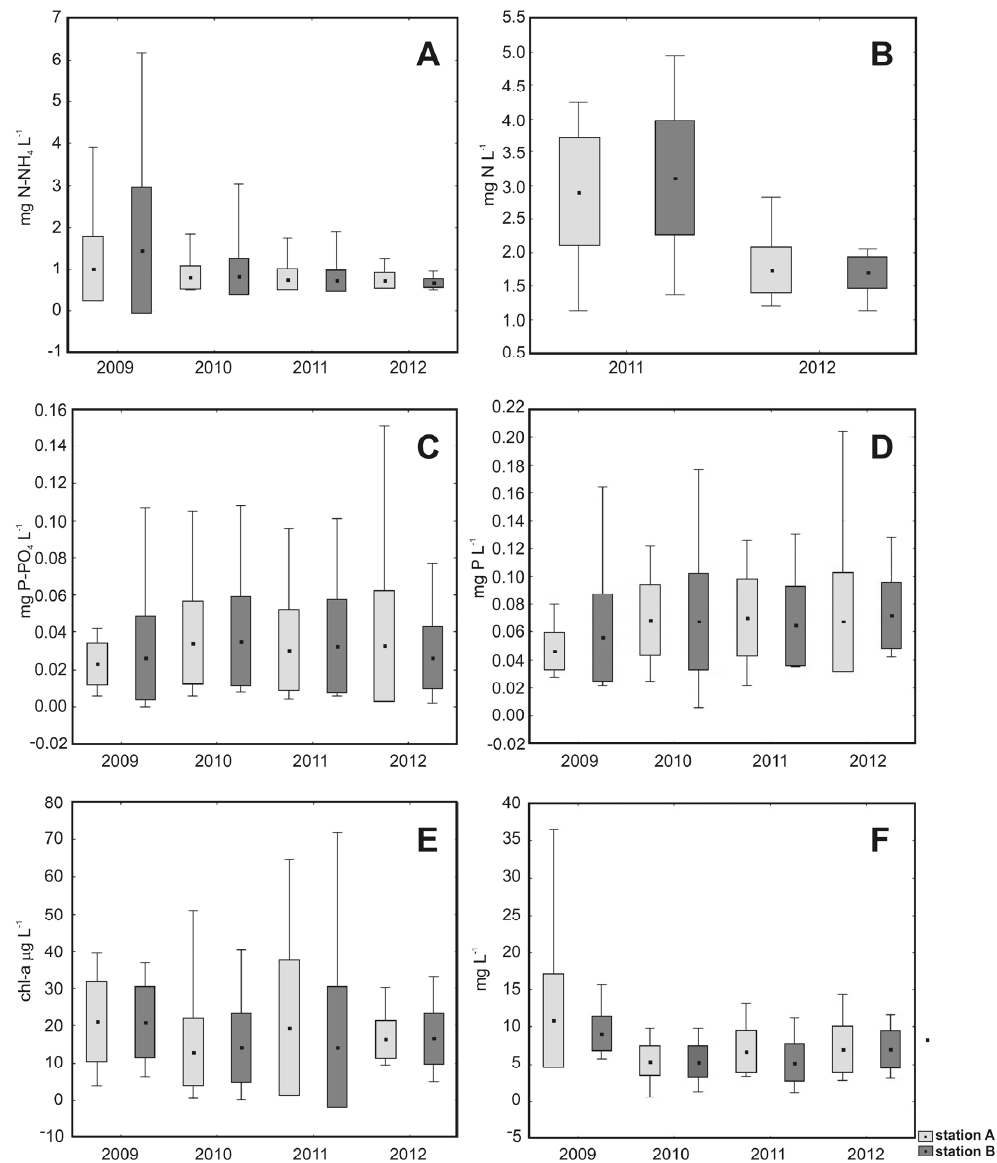
Figure 5. Mean concentration, standard deviation and max ‐ min values of analyzed water quality variables: ( A ) ammonium nitrogen; ( B ) total nitrogen; ( C ) orthophosphates; ( D ) total phosphorus; ( E ) chlorophyll ‐ a; ( F ) total suspended